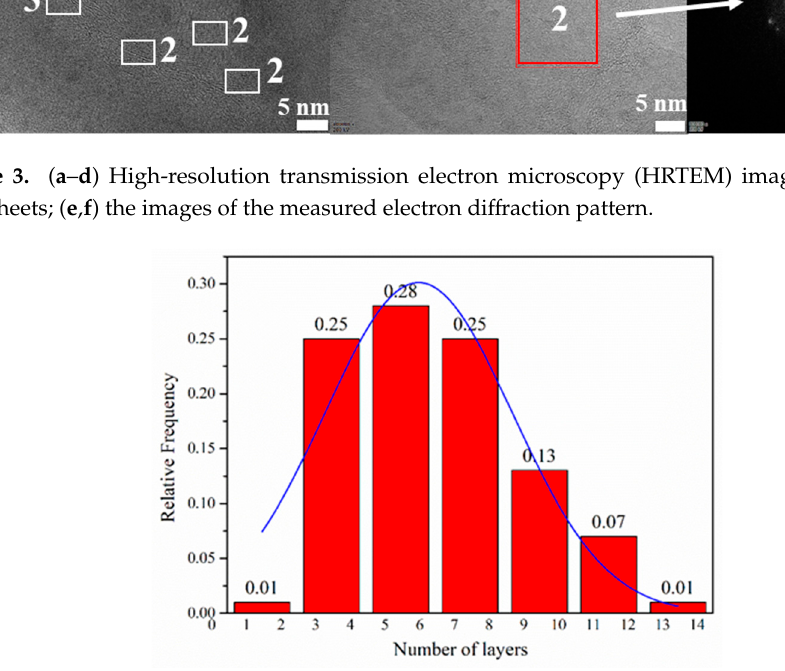
Figure 4. Flake thickness distribution measured using HRTEM analysis of the FLG nanosheets.